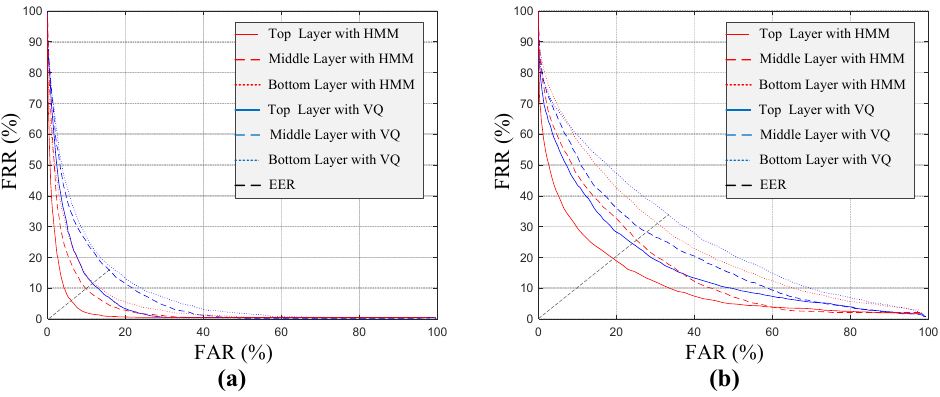
Figure 11. Detection error tradeoff (DET) curves of walker verification in: ( a ) LOS scenario; ( b ) NLOS scenario. EER: equal error rate. Table 2. Equal error rates (EERs) with respect to different sensing layers and different verification algorithms.